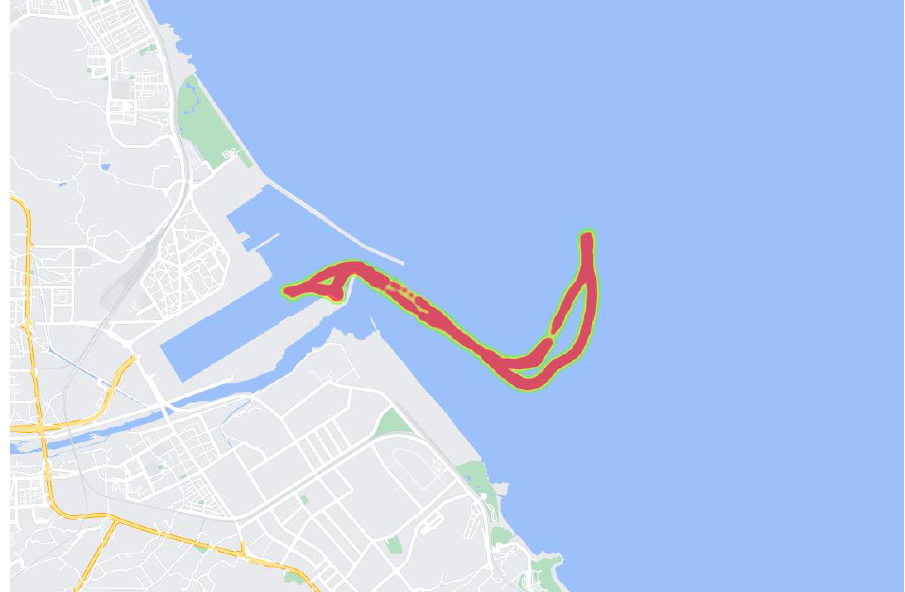
Figure 5. An example of the trajectory of a voyage.